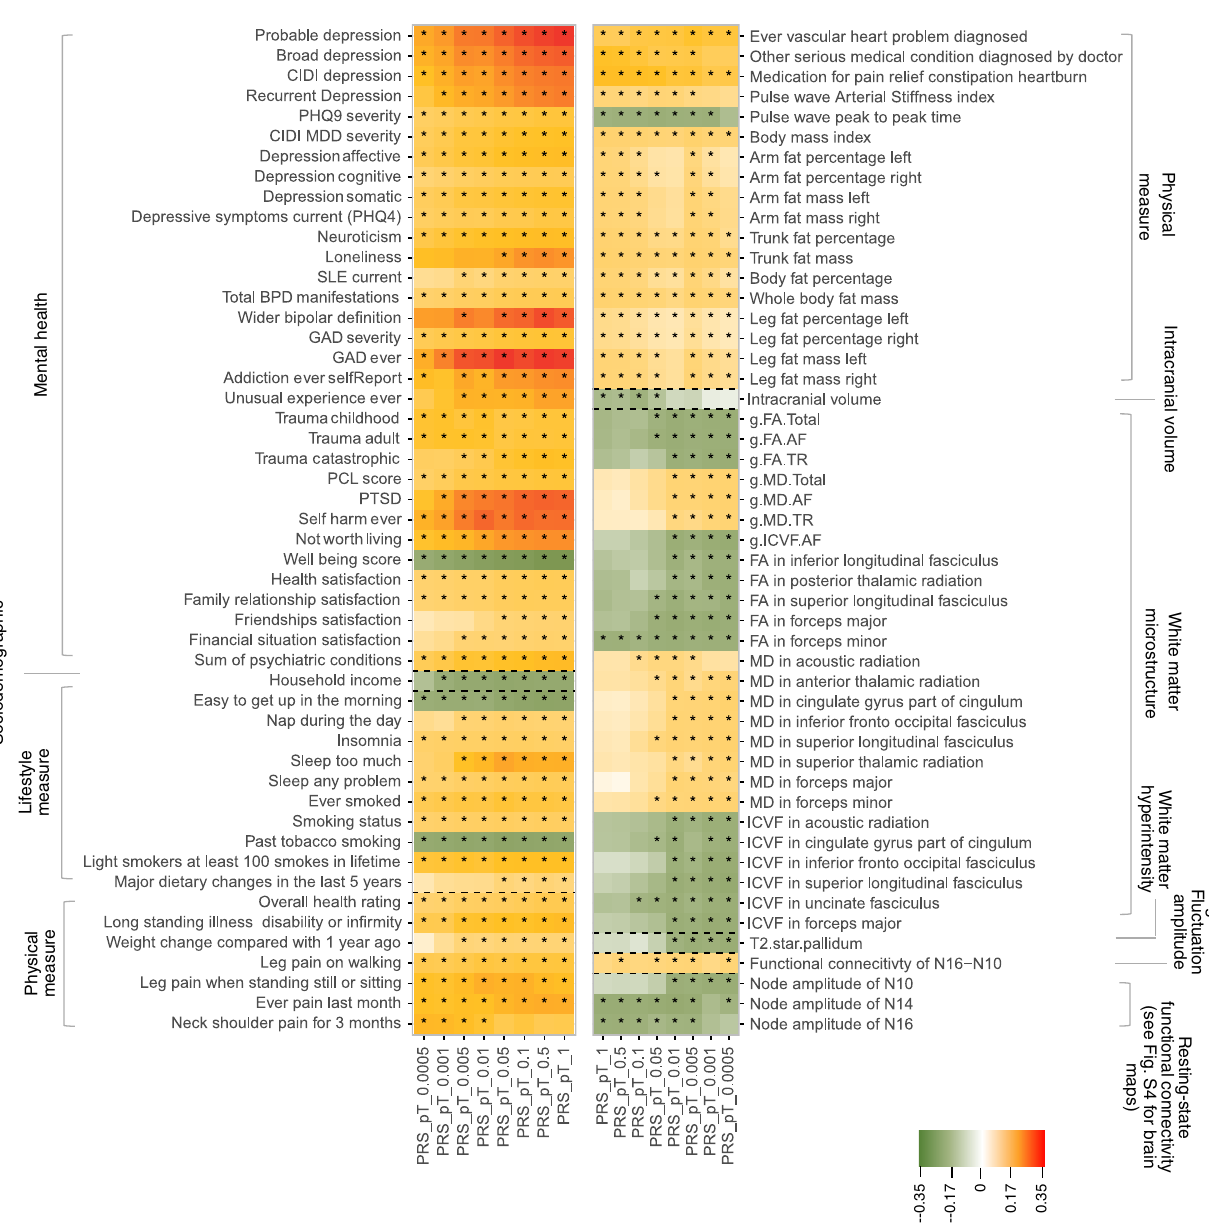
linear regression: 0.046 – 5.00 × 10 − 6 ). Bidirectional MR on imaging phenotypes and depression . A signi fi cant and potentially causal effect of depression was found on lower microstructural integrity in four white matter micro- structural measures and lower resting-state fl uctuation amplitude in the Salience Network (Node 14). For these phenotypes, the effect from depression were shown using at least two MR methods after FDR correction (Fig. 5, Supplementary Data 6 and 7 and Supplementary Figs. 7 – 11). The neuroimaging phenotypes include ( β and p FDR reported for signi fi cant effects): global gMD (gMD-Total; β : 0.125 – 0.724, p FDR for MR: 0.041 – 0.022, sig- ni fi cant for all three MR methods), gMD in thalamic radiations